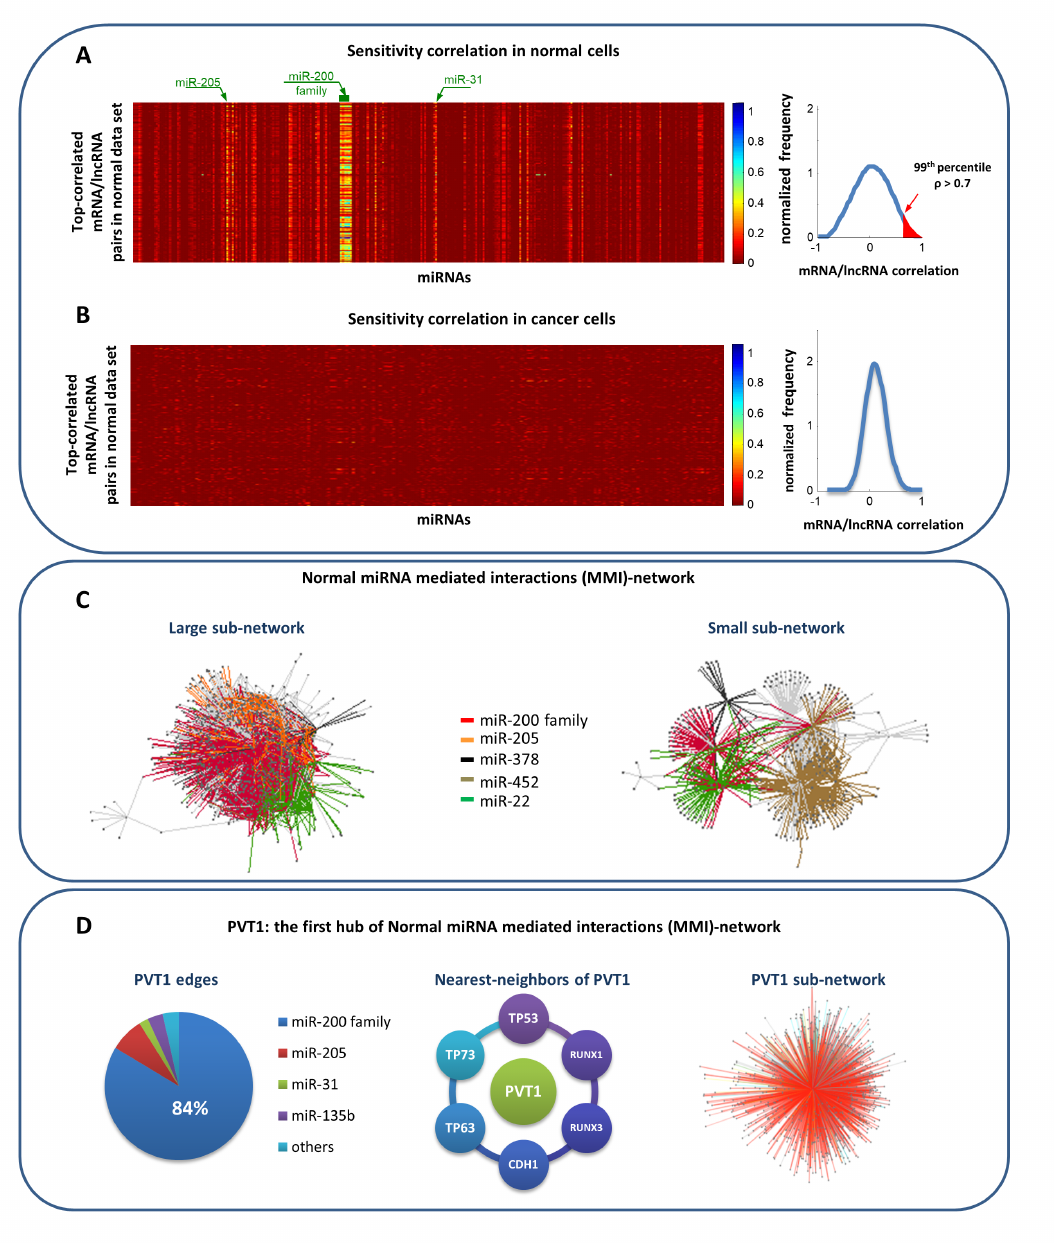
Figure 3. Results of Paci et al. model to predict miRNA sponge interactions in breast invasive carcinoma [25]. ( A ) Heatmap showing the sensitivity correlation for the top-correlated mRNA/lncRNA pairs (e.g., pairs for which the Pearson correlation between their expression profiles exceeds the 99th percentile of the overall correlation distribution) in normal breast tissues. Red color corresponds to zero sensitivity correlation, meaning that the interaction between the selected RNA pairs is direct and not mediated by miRNAs. Light vertical stripes point to miRNAs that are mediating the interaction, suggesting putative competing endogenous RNAs. ( B ) The same as in panel ( A ) but using data from breast cancer tissues. ( C ) The normal MMI-network (1738 nodes and 32,375 edges) built starting from the expression data of normal breast tissues. Nodes represent both mRNAs and lncRNAs; edges represent miRNAs that are mediating their interactions. Each pair of linked nodes fulfills two requirements: (i) sensitivity correlation > 0.3 and (ii) one or more shared MREs, for each miRNA linking them. Colors correspond to different miRNAs. ( D ) PVT1 subnetwork analysis. From left to right: the percentage of the miRNAs sponged by PVT1 with respect to all of its; some nearest neighbors of PVT1 that are well-known cancer genes; the sponge interactions sub-network of PVT1 (753 nodes and 2169